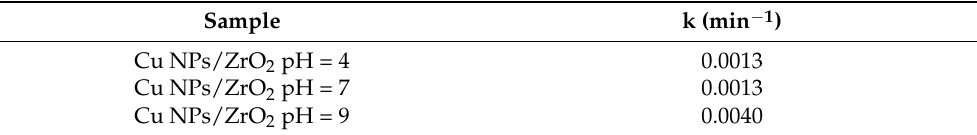
Table 5. Kinetic constant values for glycerol dehydration over Cu NP